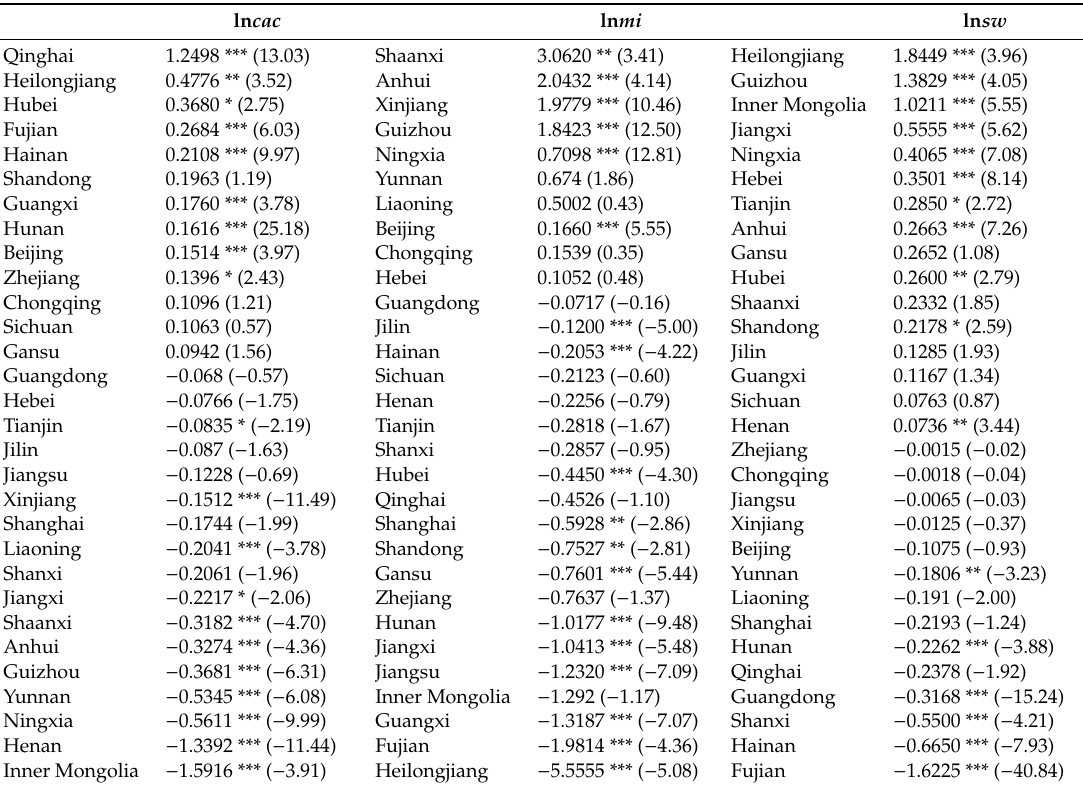
Table 5. Di ff erent types of environmental policy instruments a ff ect the provincial estimation results of green technology innovation.